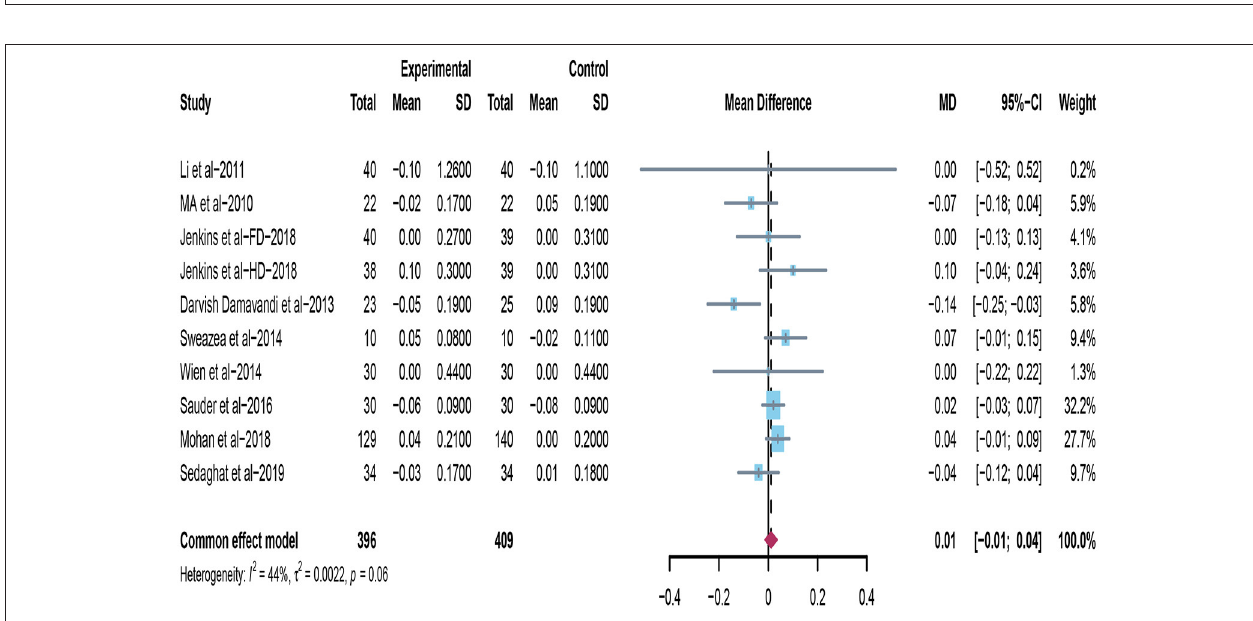
FIGURE 3 | Effect of peanuts and tree nuts supplementation on LDL-C (mmol/l) in patients with type 2 diabetes. LDL-C, low-density lipoprotein-cholesterol.